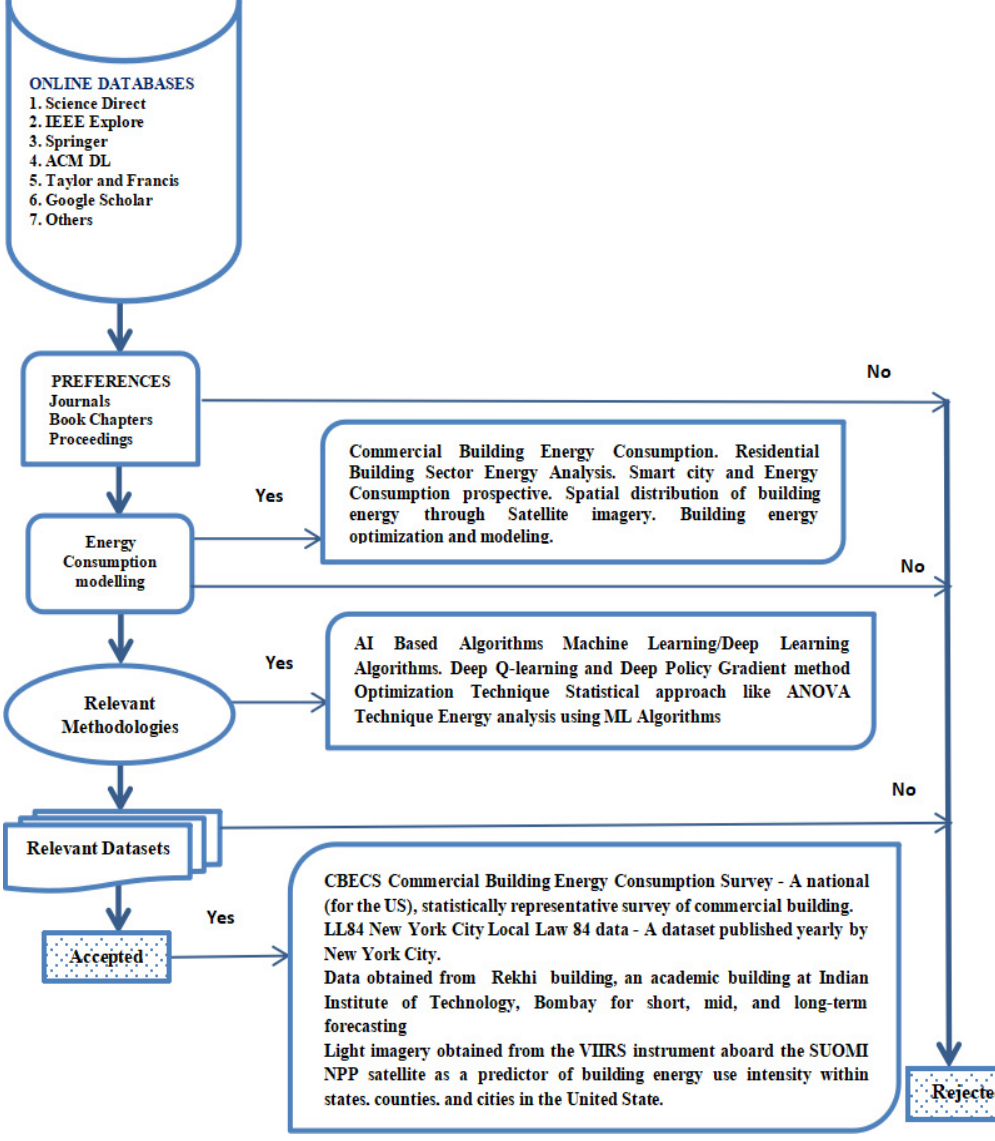
Figure 3. Flowchart of the review methodology.